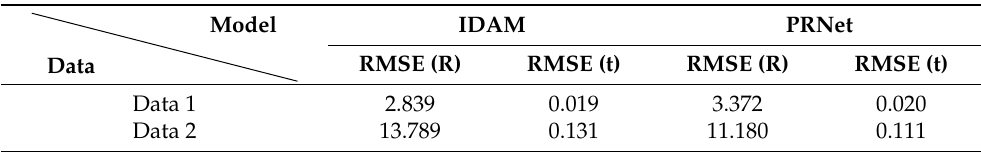
Table 2. Results of networks with different data. Data 1 represents that the source point cloud and the target point cloud use the same data, and Data 2 represents that the source point cloud and the target point cloud have inhomogeneous density.